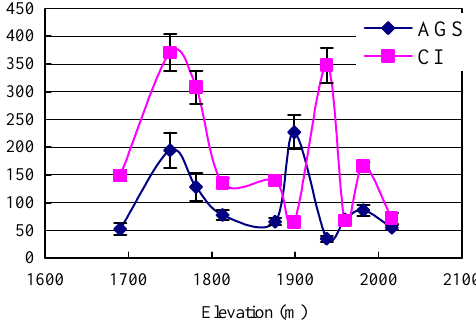
Fig. 3. Composition index (CI) and live aboveground biomass (AGS ) for each community with altitude